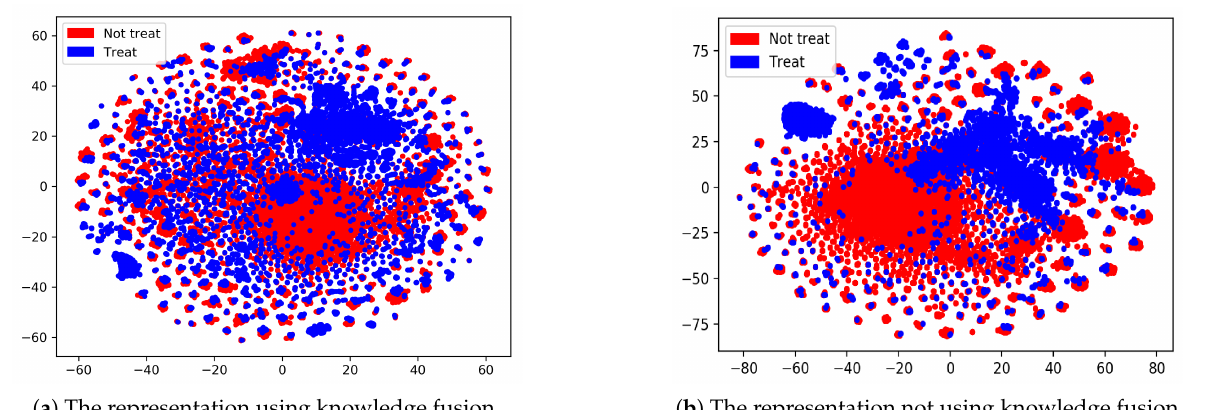
Figure 3. Two-dimensional representation of the vectors learned by TransE.